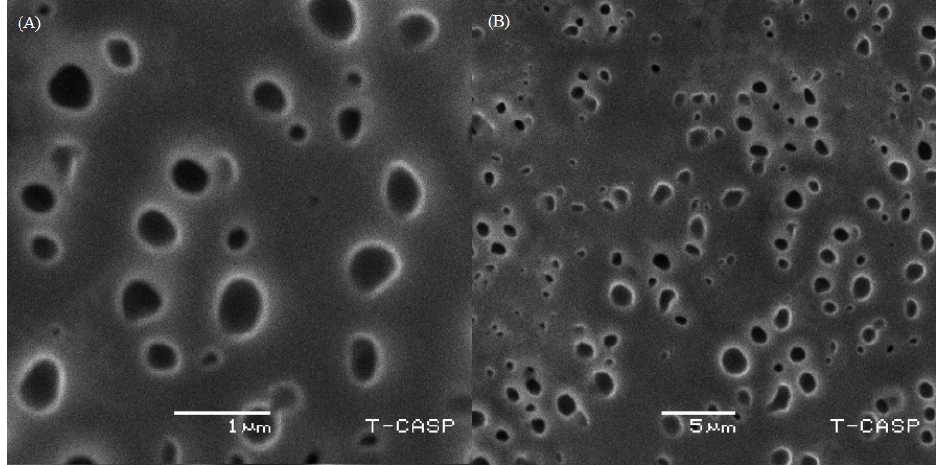
Figure 3. SEM of TE6 formulation at 1µm ( A ) and 5 µm ( B ).